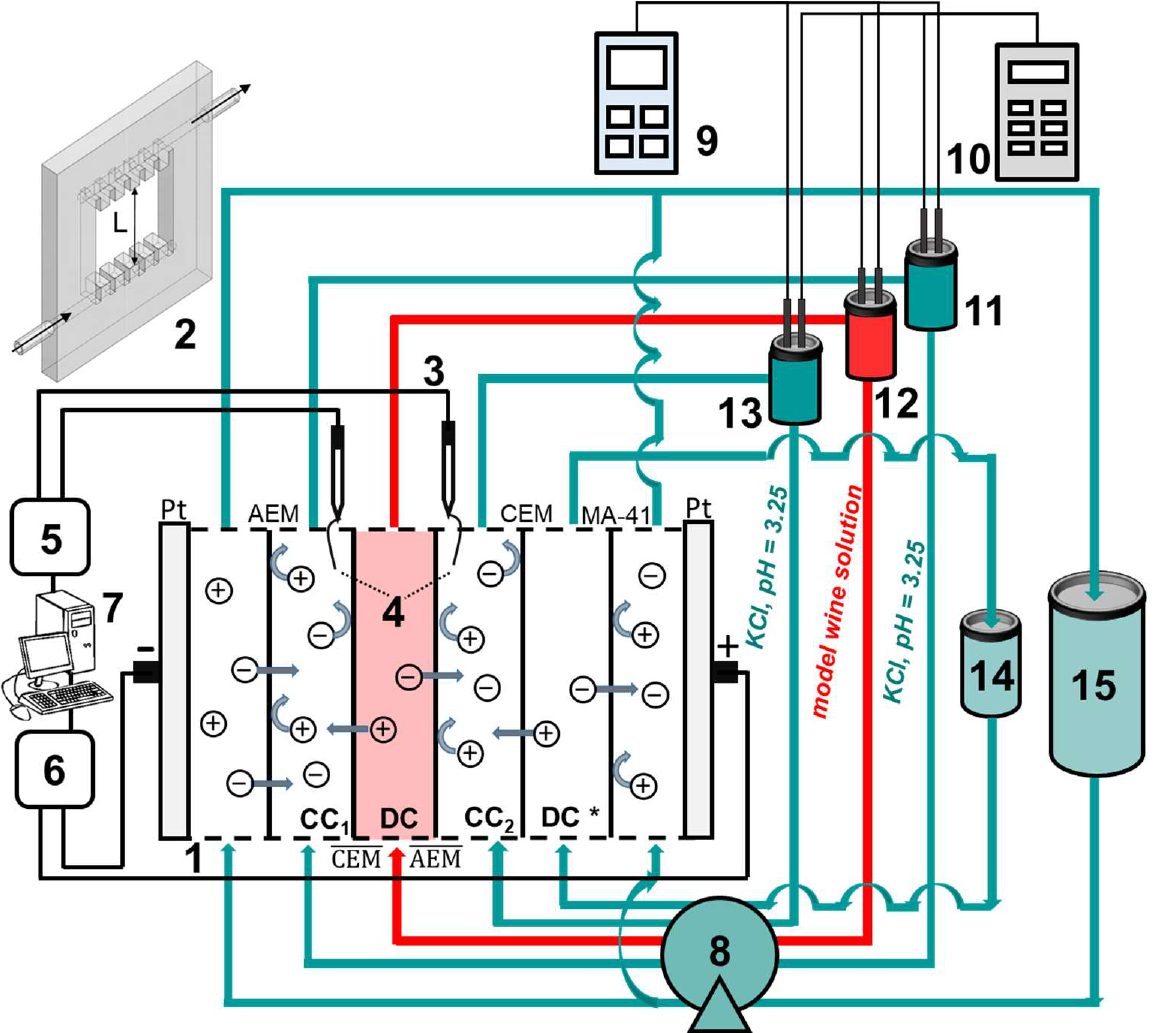
Figure 1. Scheme of the experimental setup: lab-scale ED cell (1) with membranes under study (AEM and CEM) and auxiliary membranes (CEM is identical to CEM, and AEM is identical to AEM); a plastic frame with comb inlet and outlet devices that separate the membranes (2); measuring Ag/AgCl electrodes (3) placed in microreservoirs with Luggin capillaries (4); AKIP V7-78-1 digital multimeter (Siglent, Shenzhen, China) (5); Keithley 2200-60-2 programmable power supply (Keithley Instruments, Cleveland, USA) (6); personal computer (7); Heidolph Pumpdrive 5001 peristaltic pump (Heidolph Instruments GmbH & Co., Schwabach, Germany) (8); Expert-001 pH meter (Econix-Expert Ltd., Rumyantsevo, Russia) (9); Expert-002 conductometer (Econix-Expert Ltd., Rumyantsevo, Russia) (10); intermediate tanks in the desalination (DC), concentration (CC) and electrode (EC) compartment circuits (11–15, respectively). The AEM and CEM membranes under study formed a desalination compartment (DC) through which the model solution was pumped. Auxiliary membranes AEM and CEM were used to limit the adjacent concentration compartments (CC 1 and CC 2 ). These membranes are identical to those under study. Auxiliary membrane MA-41 separated one more desalination compartment (DC *) from the anode compartment. Each